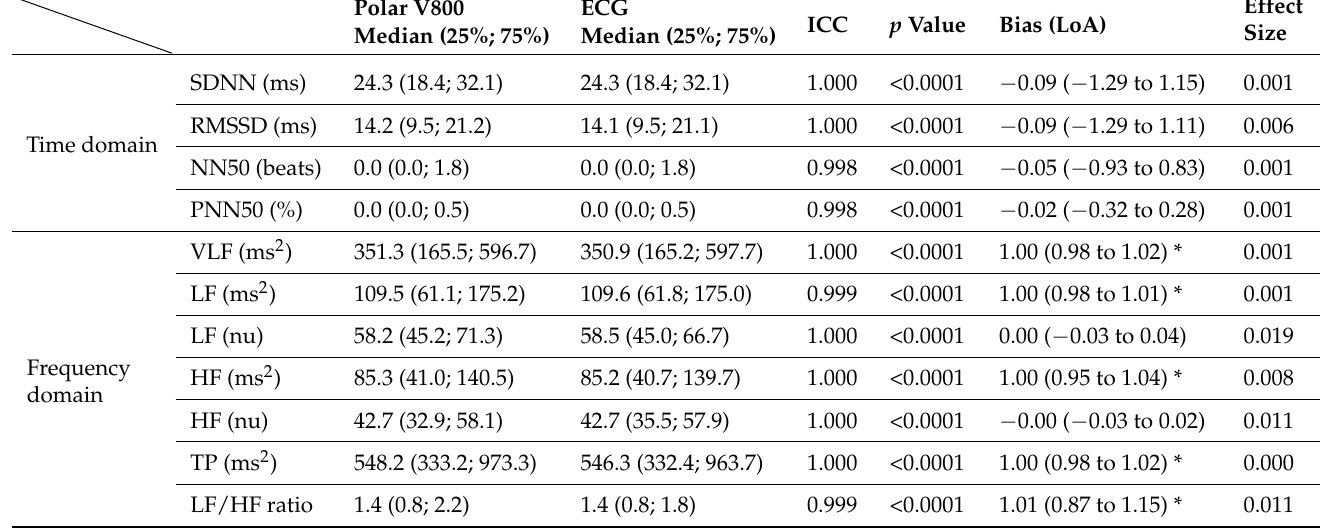
Table 4. HRV parameters for mental arithmetic test.